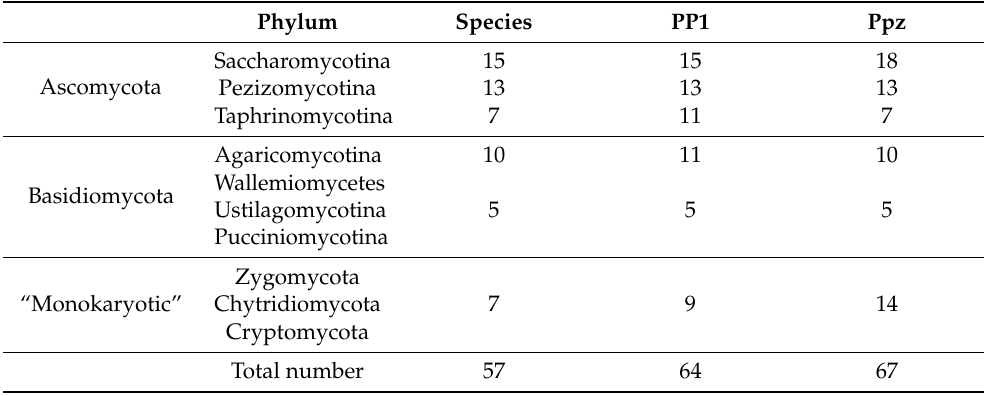
Figure 1. Simplified phylogenetical tree of the different clades covered in this study. Branches labeled as A, B and M denote the Ascomycota, Basidiomycota and “Monokarya” fungi clades. The figure was constructed based on data from reference [35]. Table 1. Distribution of selected organisms and their analyzed sequences among different fungal clades.